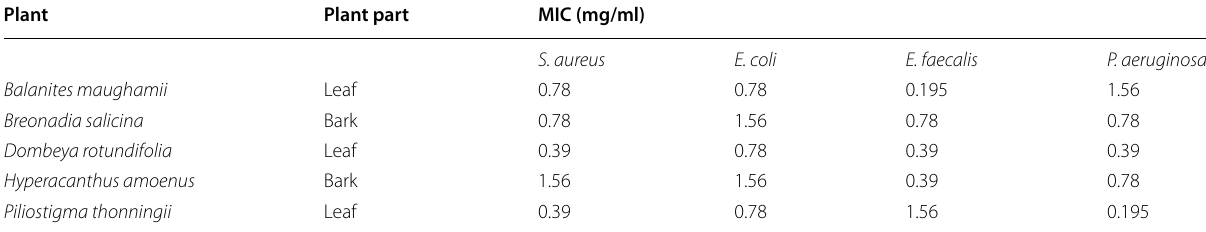
MIC minimum inhibitory concentration